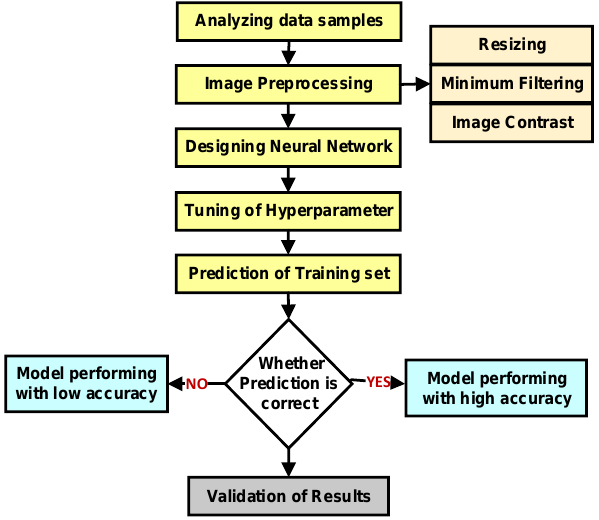
Fig. 2. Complete flowchart of proposed Research